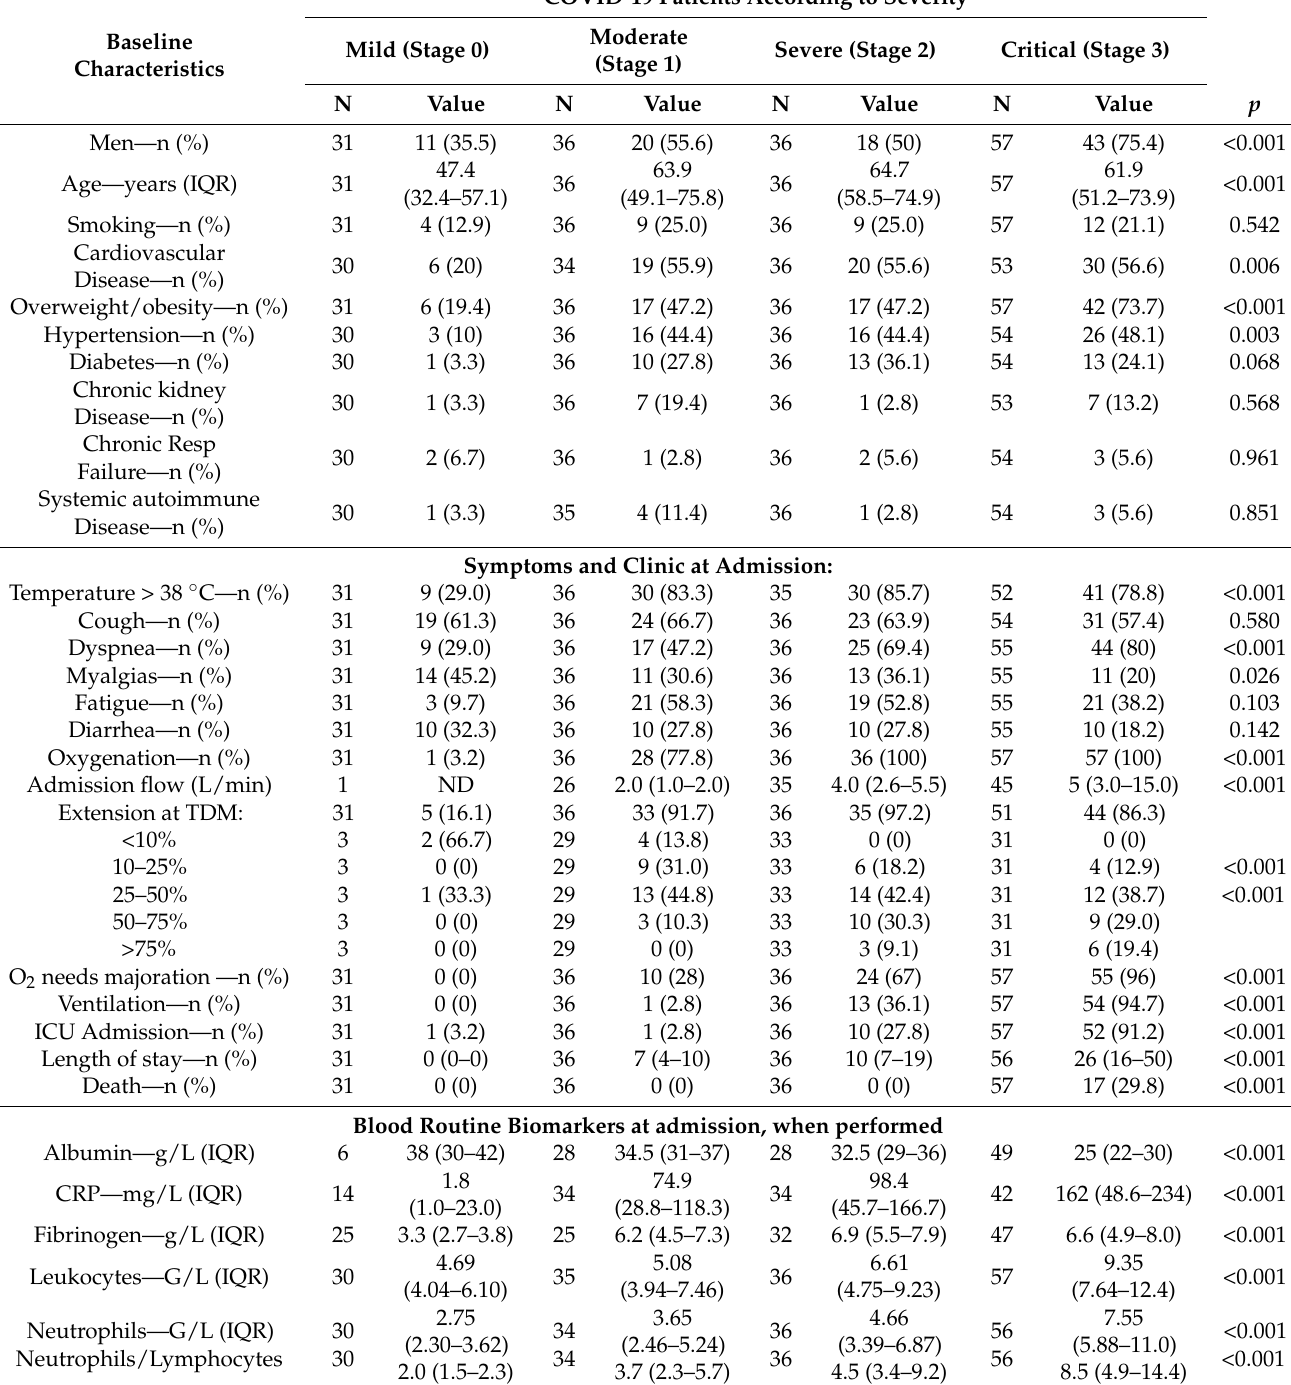
Table 1. Baseline characteristics of the studied